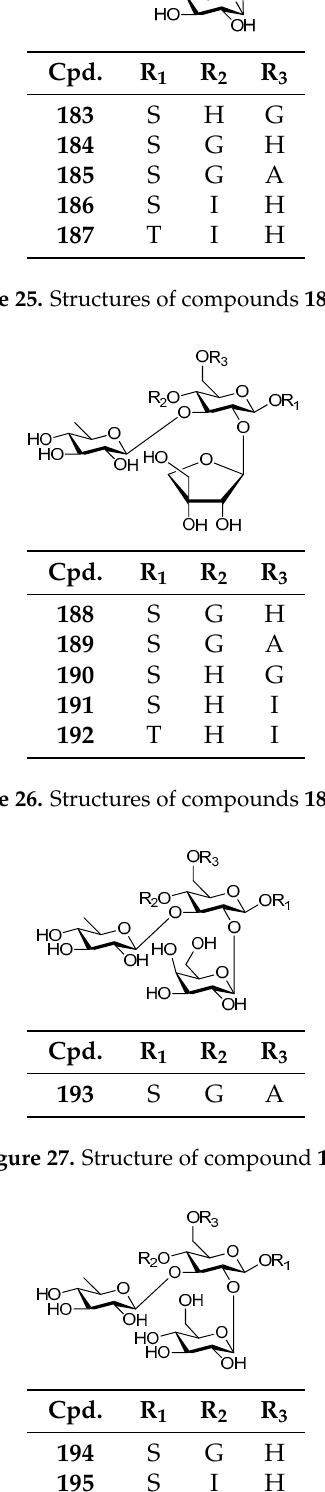
Figure 28. Structures of compounds 194 – 195 .